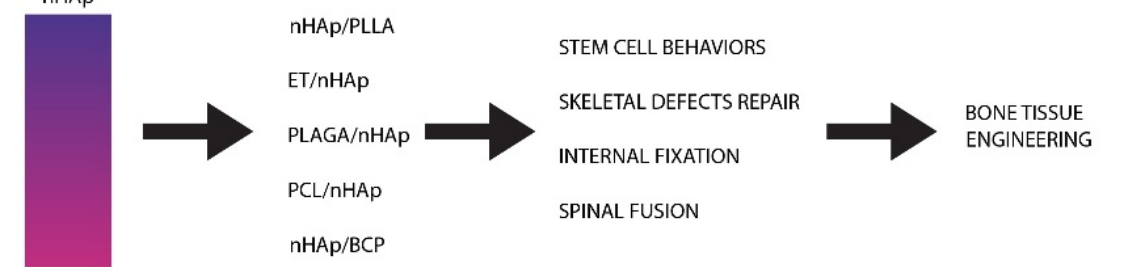
Figure 5. The application of nanohydroxyapatite (n-HAp) scaffolds in bone tissue engineering. PLGA, polylactide-co-glycolide.